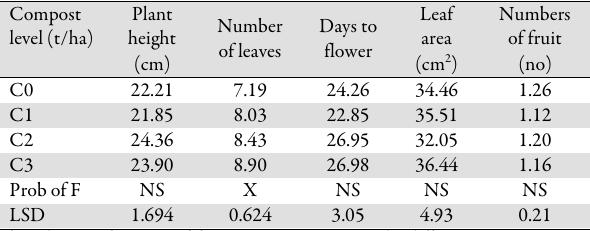
Table 3. Effect of different compost application rates on the vegetative growth of okra in the pot